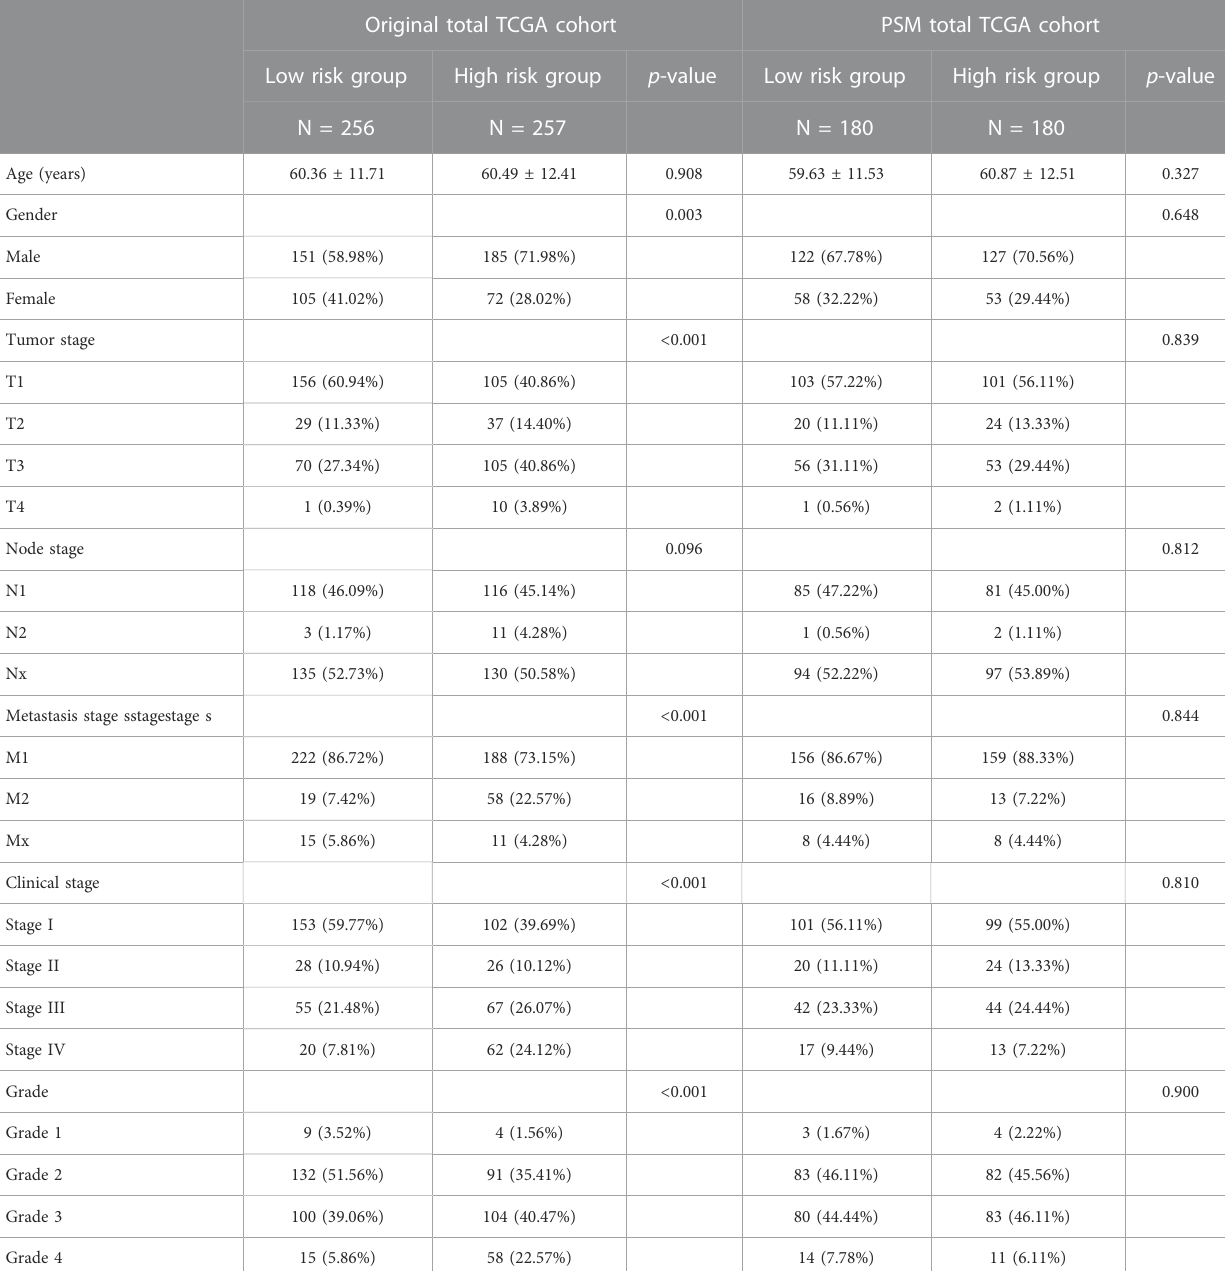
TABLE 1 The clinical feature in different risk group in total TCGA and total TCGA cohort after